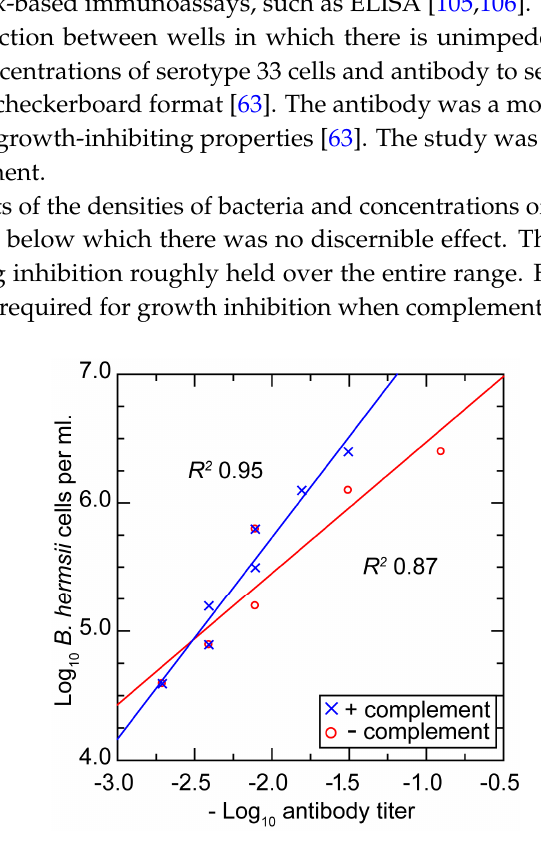
Figure 8. Scatter plot of in vitro growth inhibition assay titers at different densities (log-transformed) of B. hermsii cells and different titers (log-transformed) of a monoclonal antibody to B. hermsii and in presence or absence of complement. Linear regression for each of the two conditions and corresponding coefficients of determination ( R 2 ) are shown.